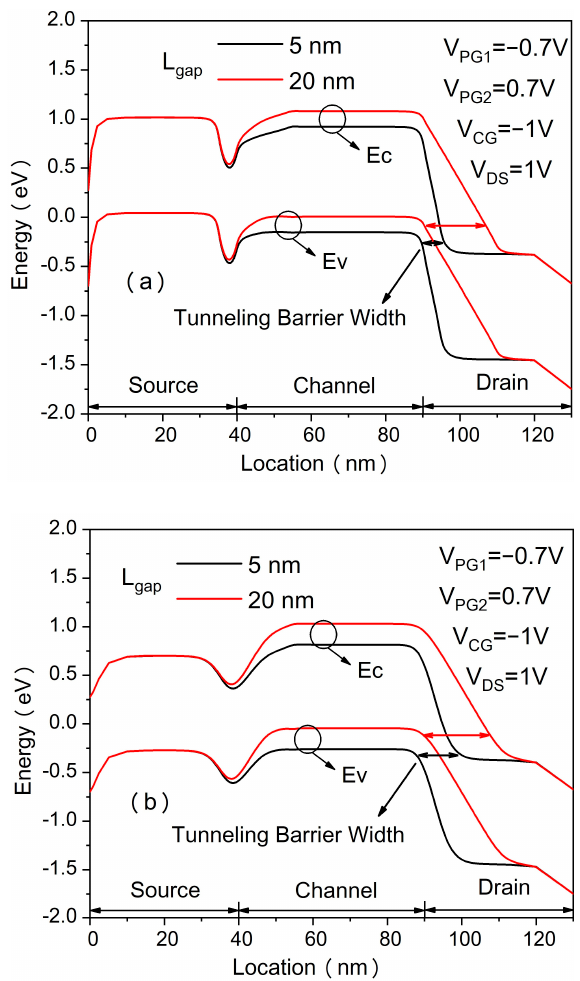
Figure 2. Transfer characteristics of proposed in-built N + pocket ED-TFET with an ED drain and conventional in-built N + pocket ED-TFET with uniformly doped drain.